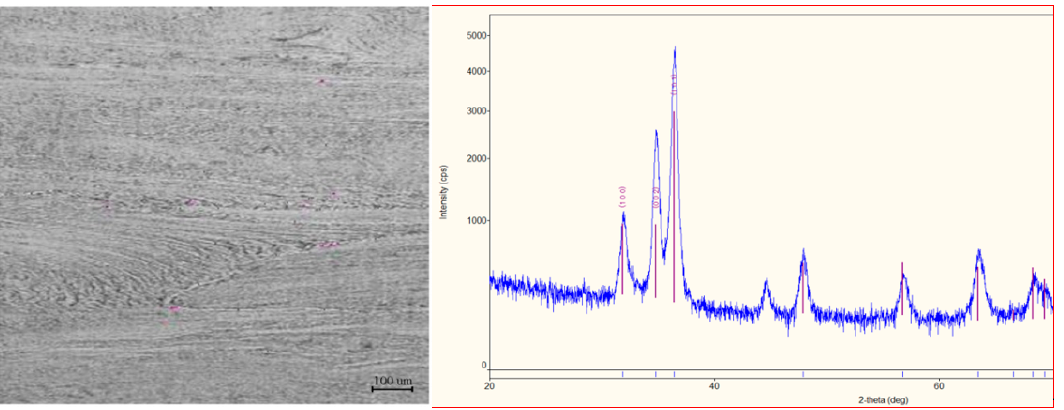
Figure 3. Microstructure of longitudinal section (×200) and diffractogram of the initial Zr-1% Nb alloy.